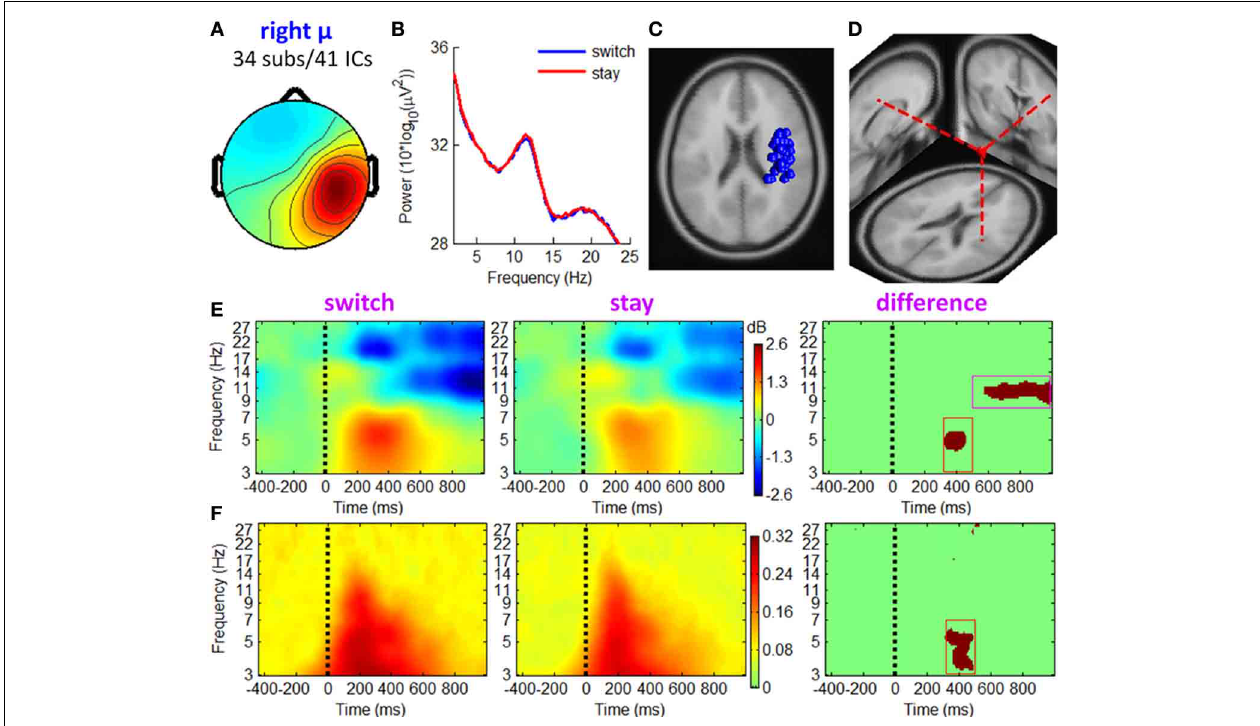
FIGURE 8 | IC properties of right mu rhythm cluster. (A) Mean scalp maps across 41 ICs. (B) Mean power spectra. (C) Equivalent dipole locations of 41 ICs. (D) Mean dipole location and orientation. (E) Mean ERSP image. (F) Mean ITC image.